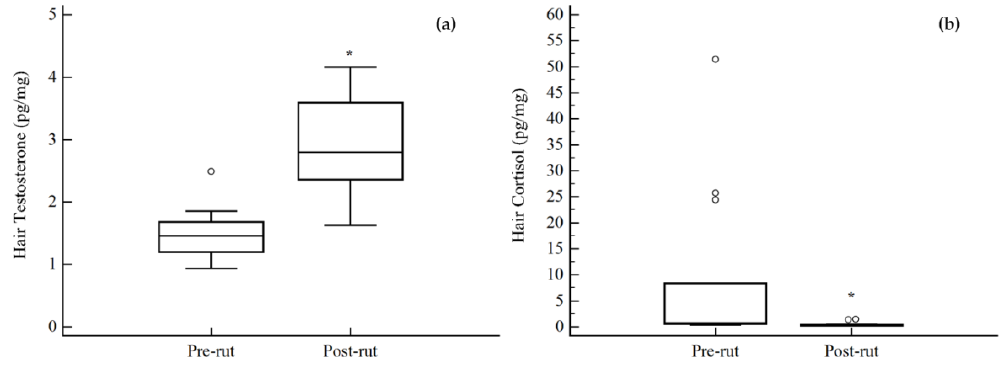
Figure 3. Differences between pre- and post-rut groups for the hair steroid hormone concentrations. ( a ) Testosterone; ( b ) cortisol. ○ outlier; * p < 0.05.